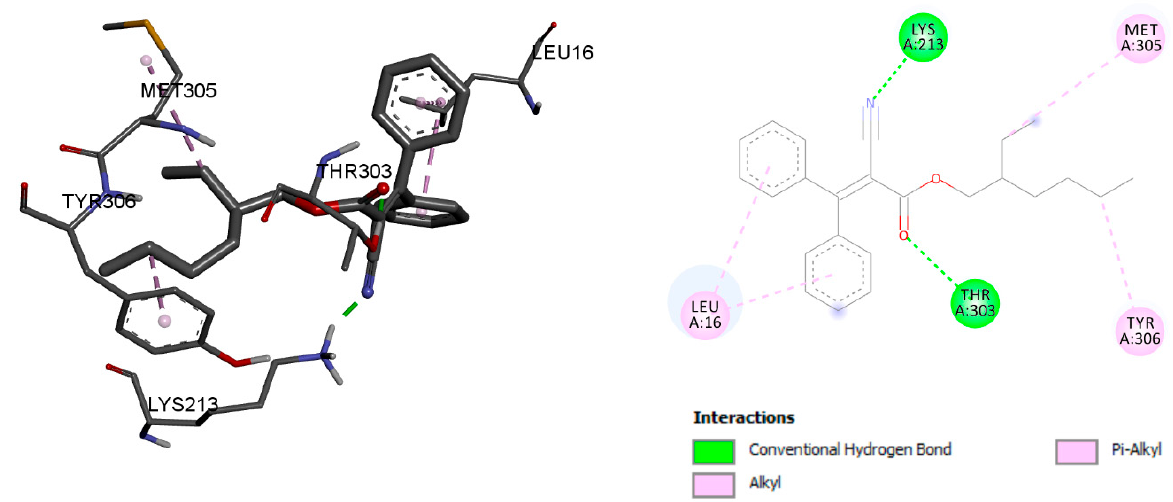
Figure 2. Octocrylene molecular interaction with the vitamin D binding protein.